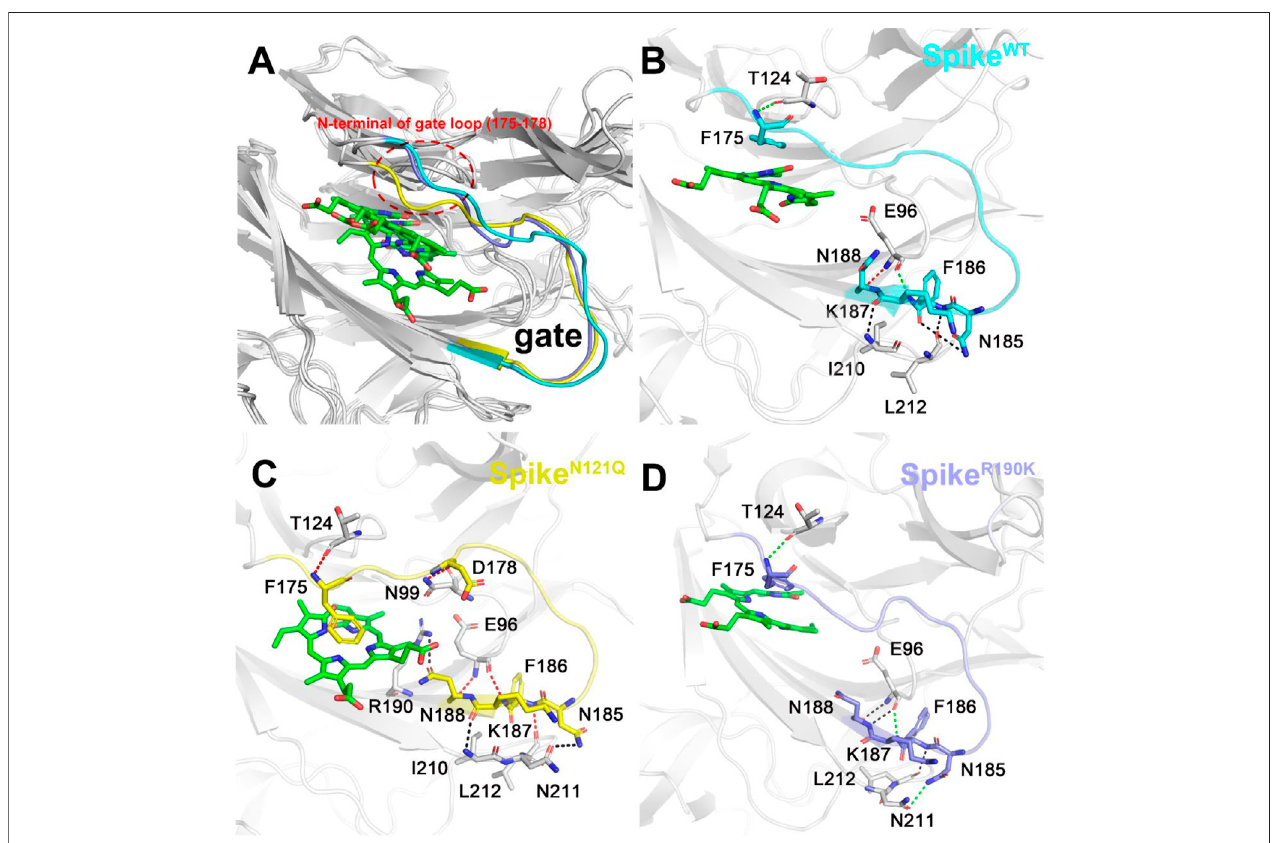
FIGURE 7 | Three different colors, red, green, and black, representing strong, moderate, and weak hydrogen bond interactions, were applied according to their probabilityrangeof > 80%,60% – 80%,and30% – 60%,respectively. (A) Comparisonofthegateloopsinthreesystems.Illustrationofhydrogenbondinteractionofthelip (B) in Spike WT /Biliverdin, (C) in Spike N121Q /Biliverdin, and (D) in Spike R190K